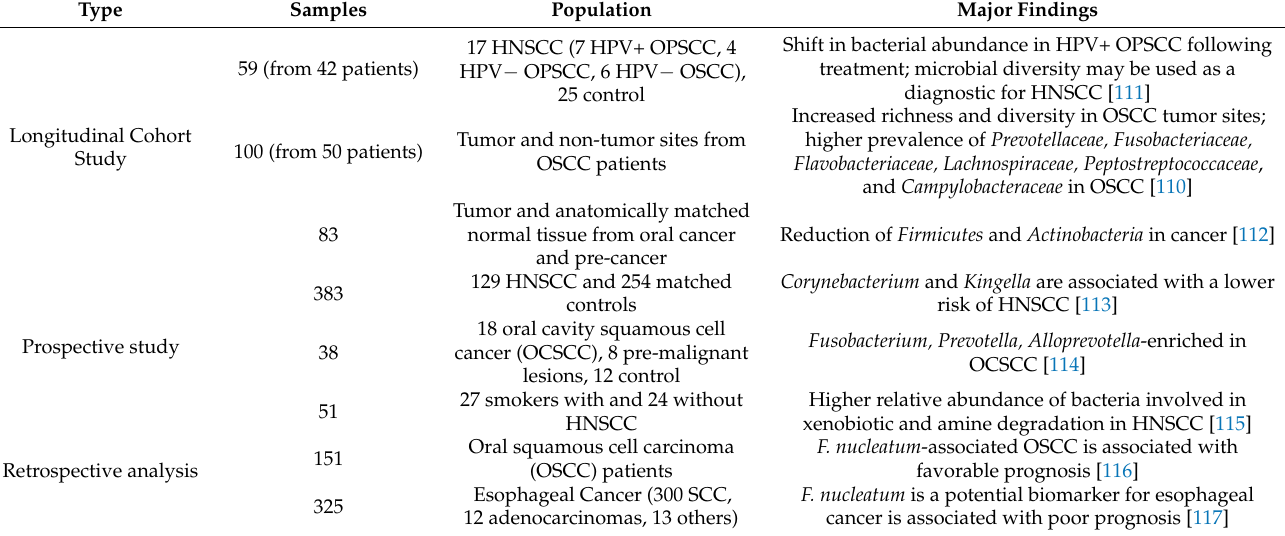
Table 1. Microbiome studies in HNSCC